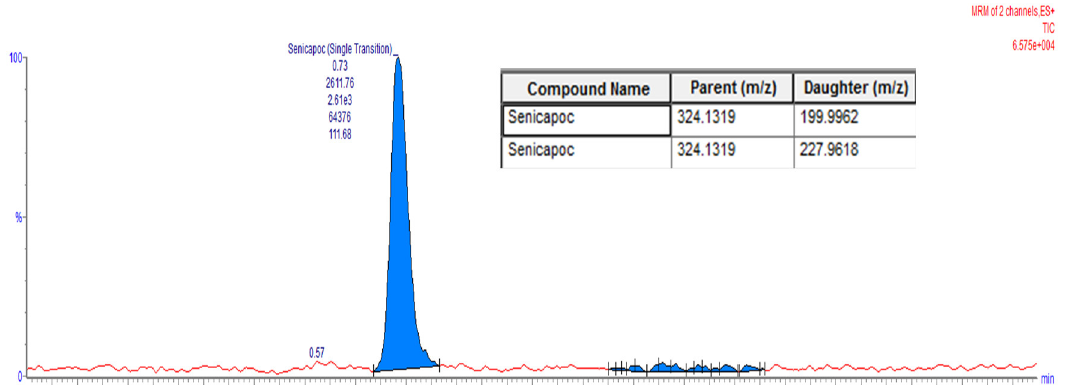
Figure 2. Liquid Chromatography Mass Spectroscopy (LC-MS) Chromatogram of Senicapoc.